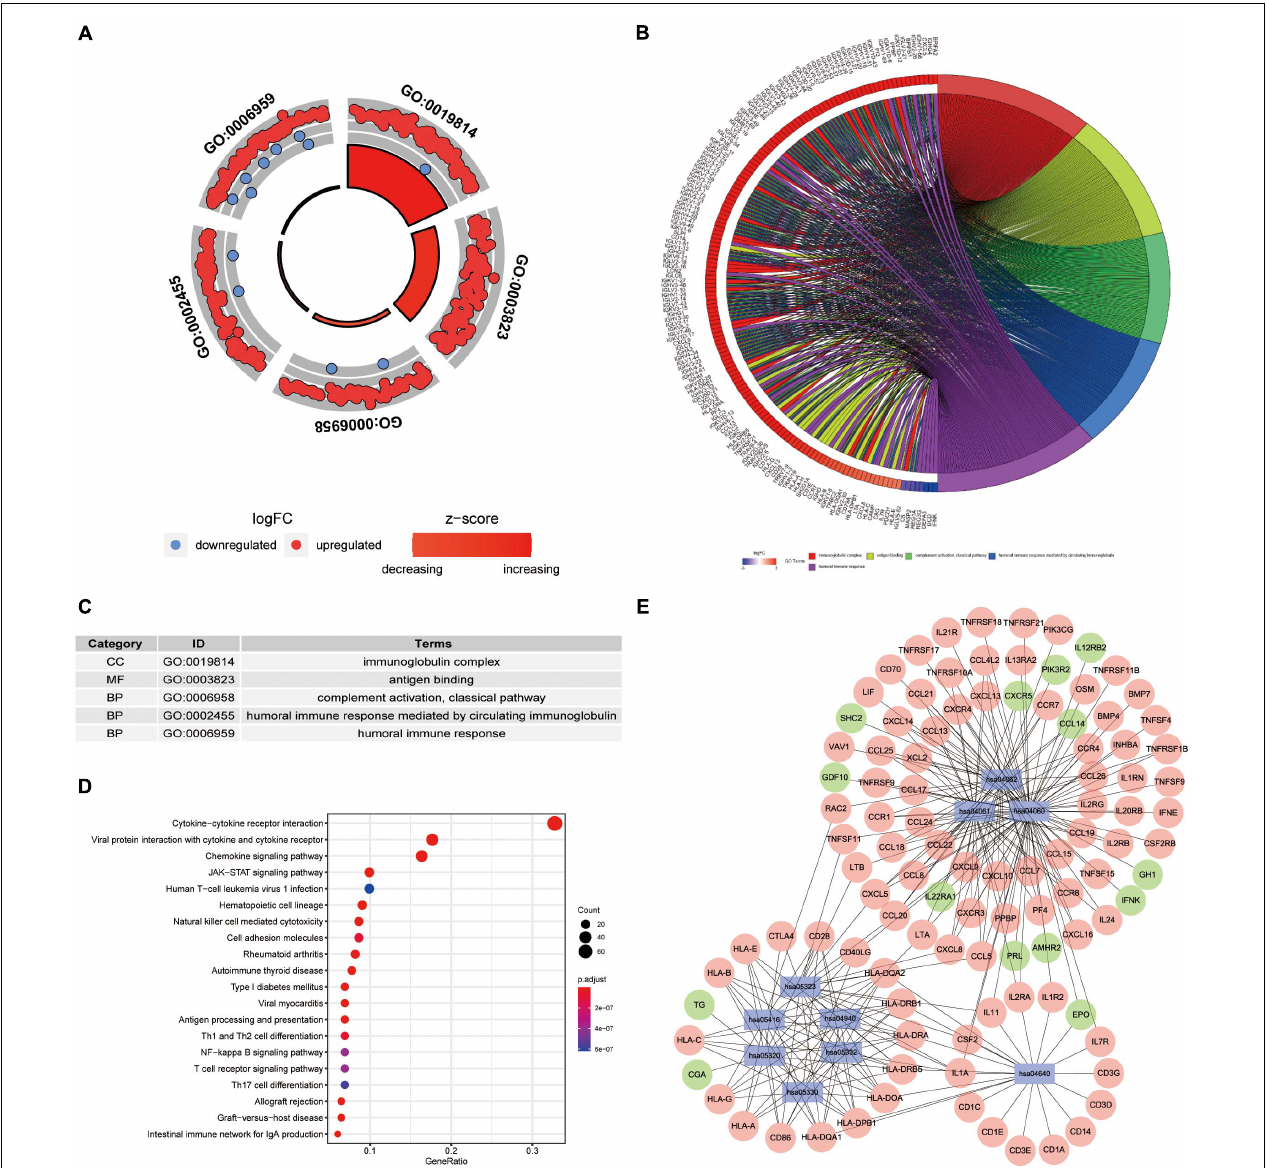
FIGURE 3 | Functional-enrichment analyses of DEIRGs in PAAD. (A) The outer circle shows expression (log FC) of DEIRGs in each enriched Gene Ontology (GO) term: red dots which are on each GO term indicate upregulation of DEIRGs. Blue dots indicate downregulated DEIRGs. The inner circle shows the prominence of GO terms (log10-adjusted P -values). (B) The circle represents the relationship between the top-five most significant GO terms and their related DEIRGs. (C) The top-five most significant GO terms and their annotations. (D) The top-20 pathways enriched in DEIRGs are shown in the bubble plot. (E) The top-10 pathways and the corresponding DEIRGs. The blue rectangles represent Kyoto Encyclopedia of Genes and Genomes (KEGG) pathways. The red ellipses indicate upregulated DEIRGs. The green ellipses indicate downregulated